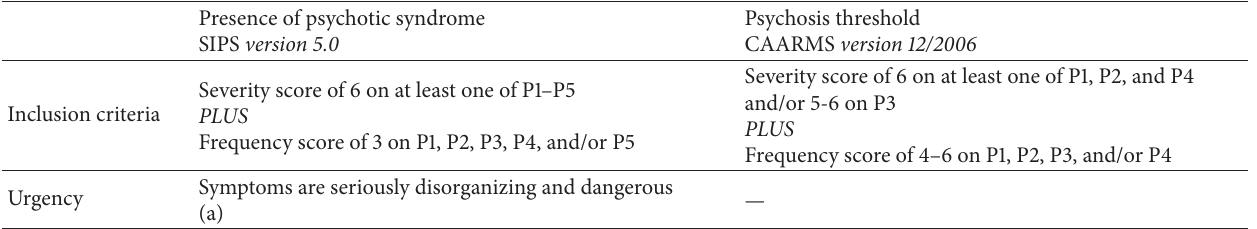
Table 2: Psychosis threshold: similarities and differences between the SIPS 5.0 and the CAARMS